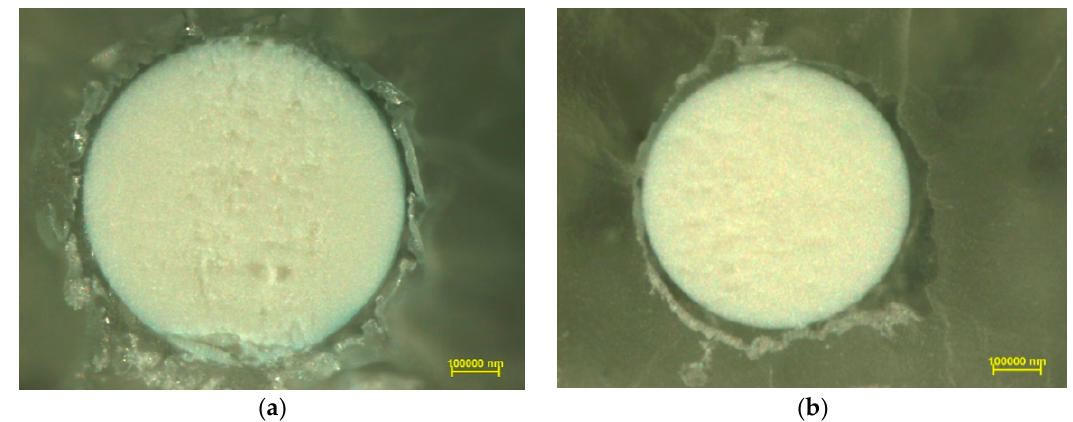
Figure 3. Photographs of cut ( a ) Purolite S 940, ( b ) Purolite S 950 after the Cu(II) ion sorption process.